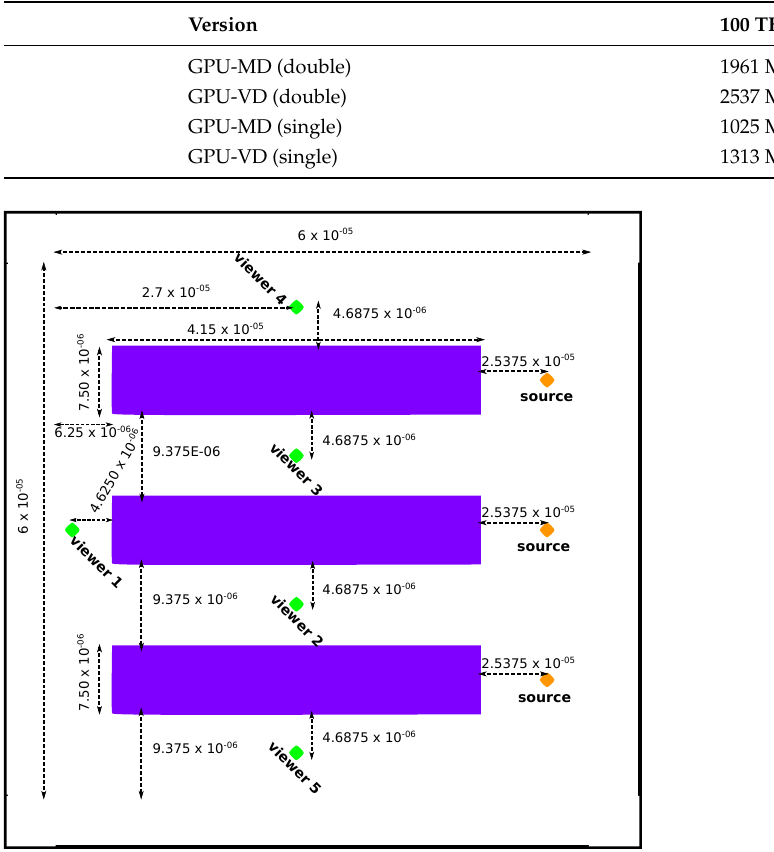
Figure 20. Configuration for the nanowaveguide simulation scenario. The orange dots indicate the sources, and the green dots the position of the numerical control points. The simulation lasted 3000 time steps, and the sources were turned off at